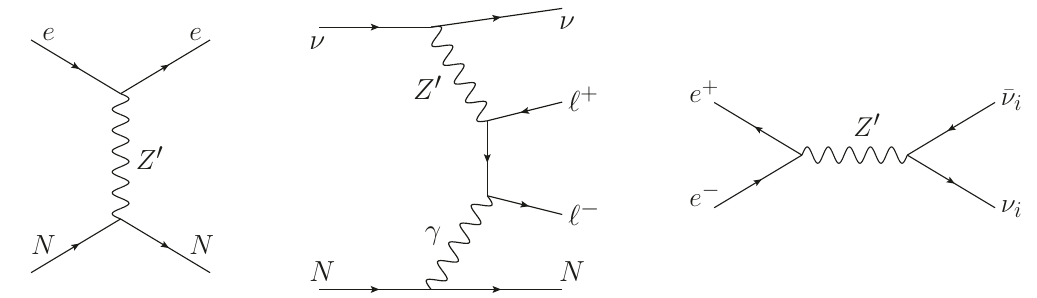
Figure 15 . Representative diagrams relevant for (from left to right) atomic parity violation, neutrino trident production, and white dwarf cooling